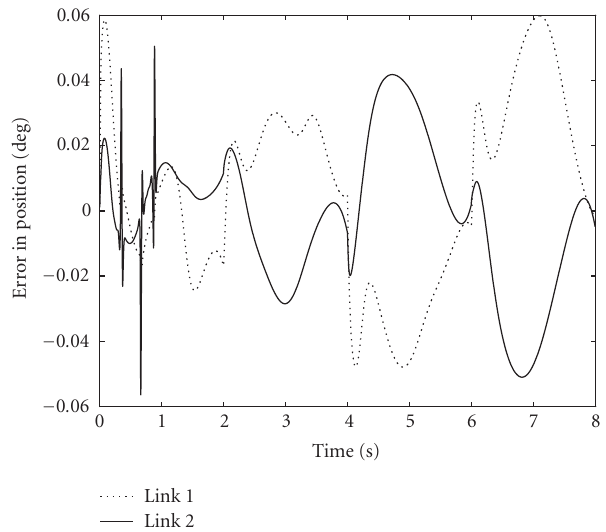
Figure 15: Errors for ACDIDC + fuzzy control (trajectory 2).